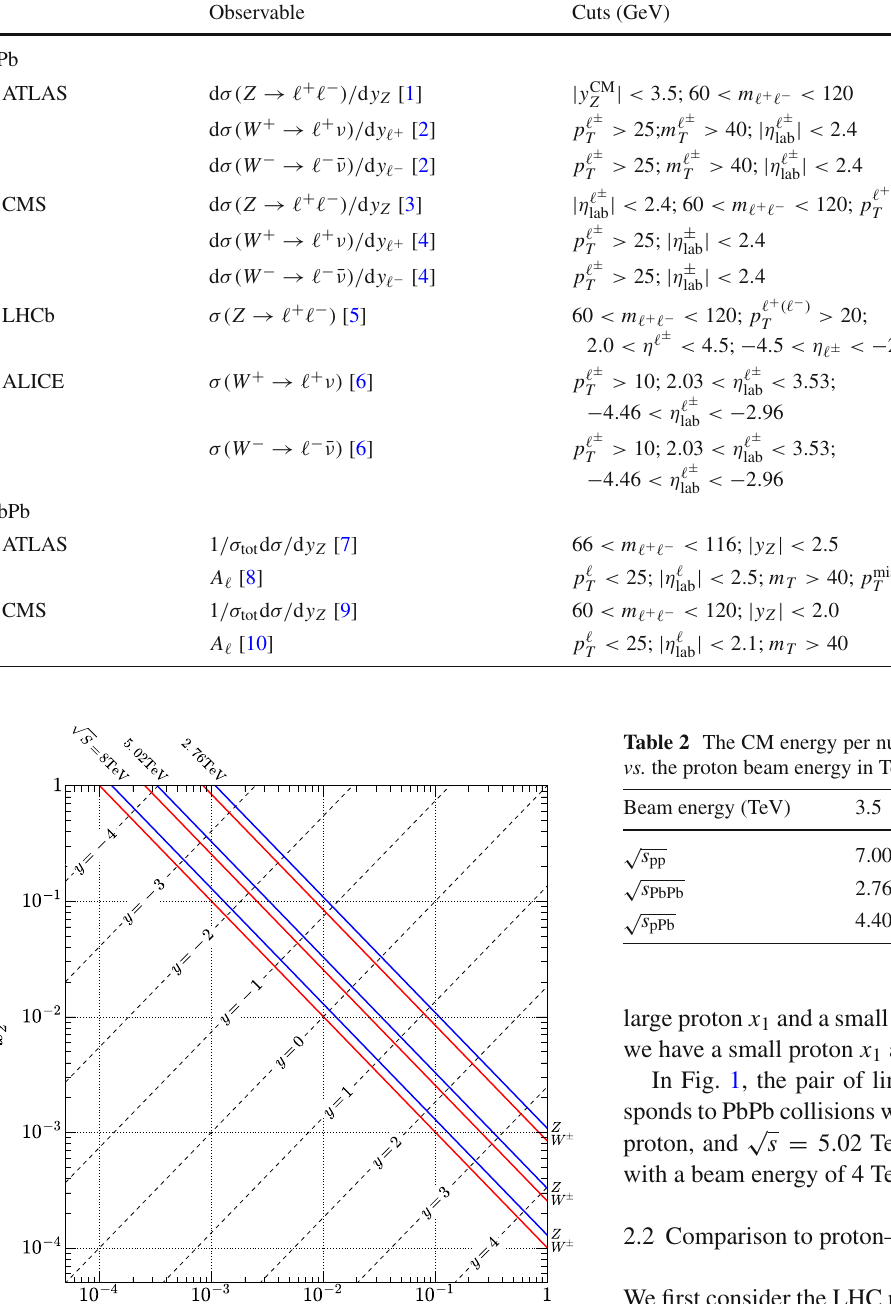
Table 1 LHC data sets considered in this analysis Observable Cuts (GeV)